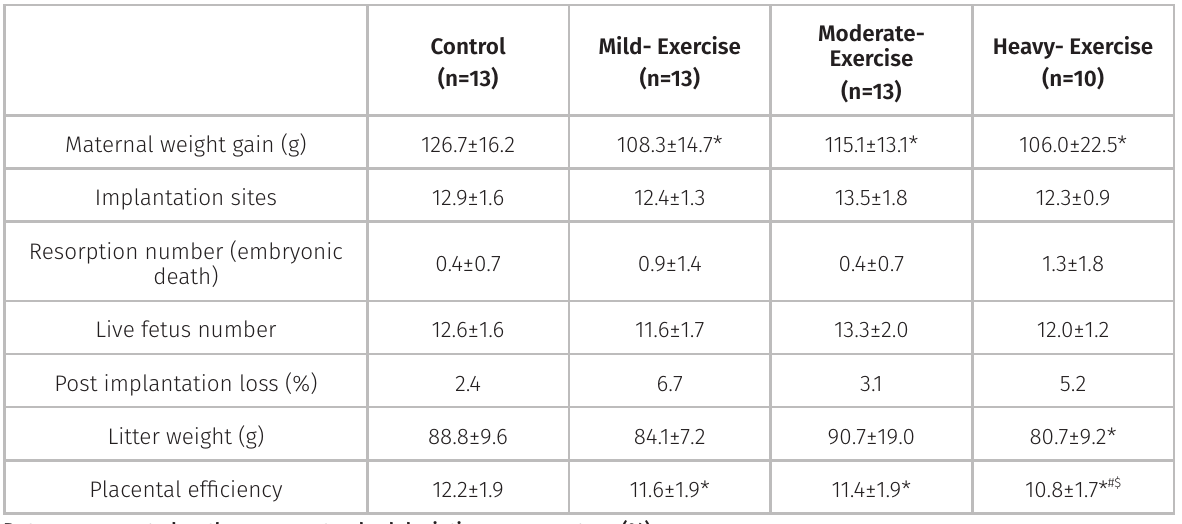
Table III. Maternal reproductive performance of rats submitted to mild, moderate and heavy-exercise intensity during pregnancy. Moderate- Heavy- Exercise Control Mild- Exercise Exercise (n=10) (n=13) (n=13) (n=13) Maternal weight gain (g) 126.7±16.2 108.3±14.7* 115.1±13.1* 106.0±22.5* Implantation sites 12.9±1.6 12.4±1.3 13.5±1.8 12.3±0.9 Resorption number (embryonic 0.4±0.7 0.9±1.4 death) Live fetus number Post implantation loss (%) Litter weight (g) Placental